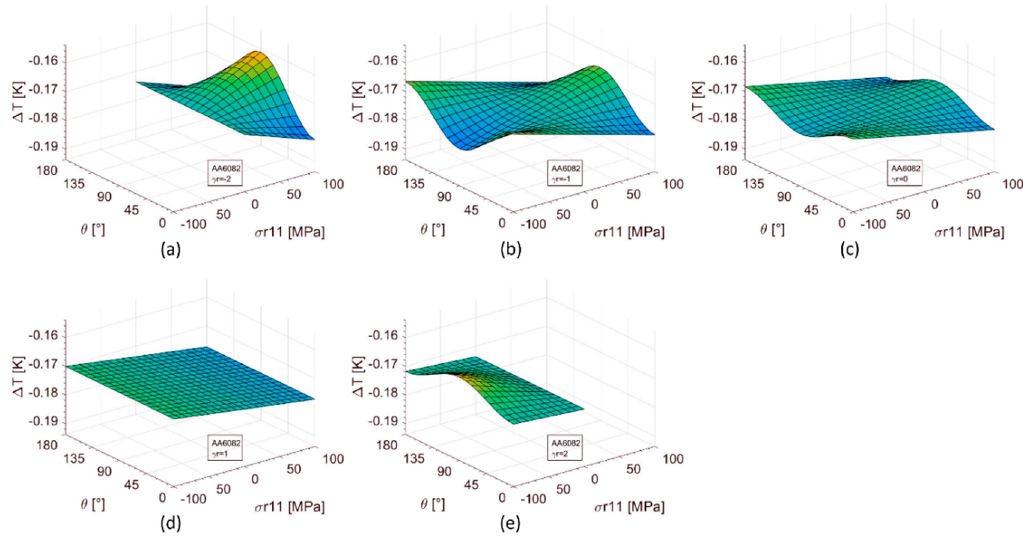
σ θ for the AA6082 r11 and